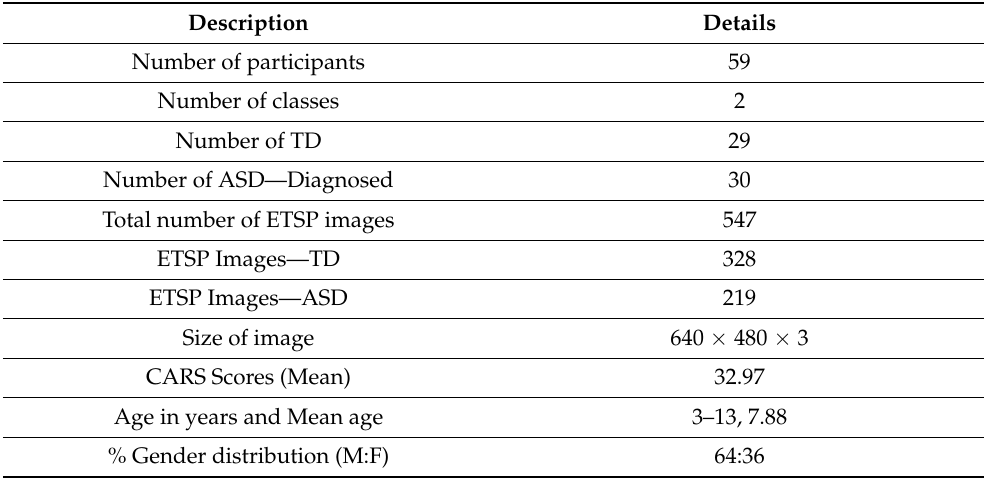
Table 1. Summary of the ETSP Image